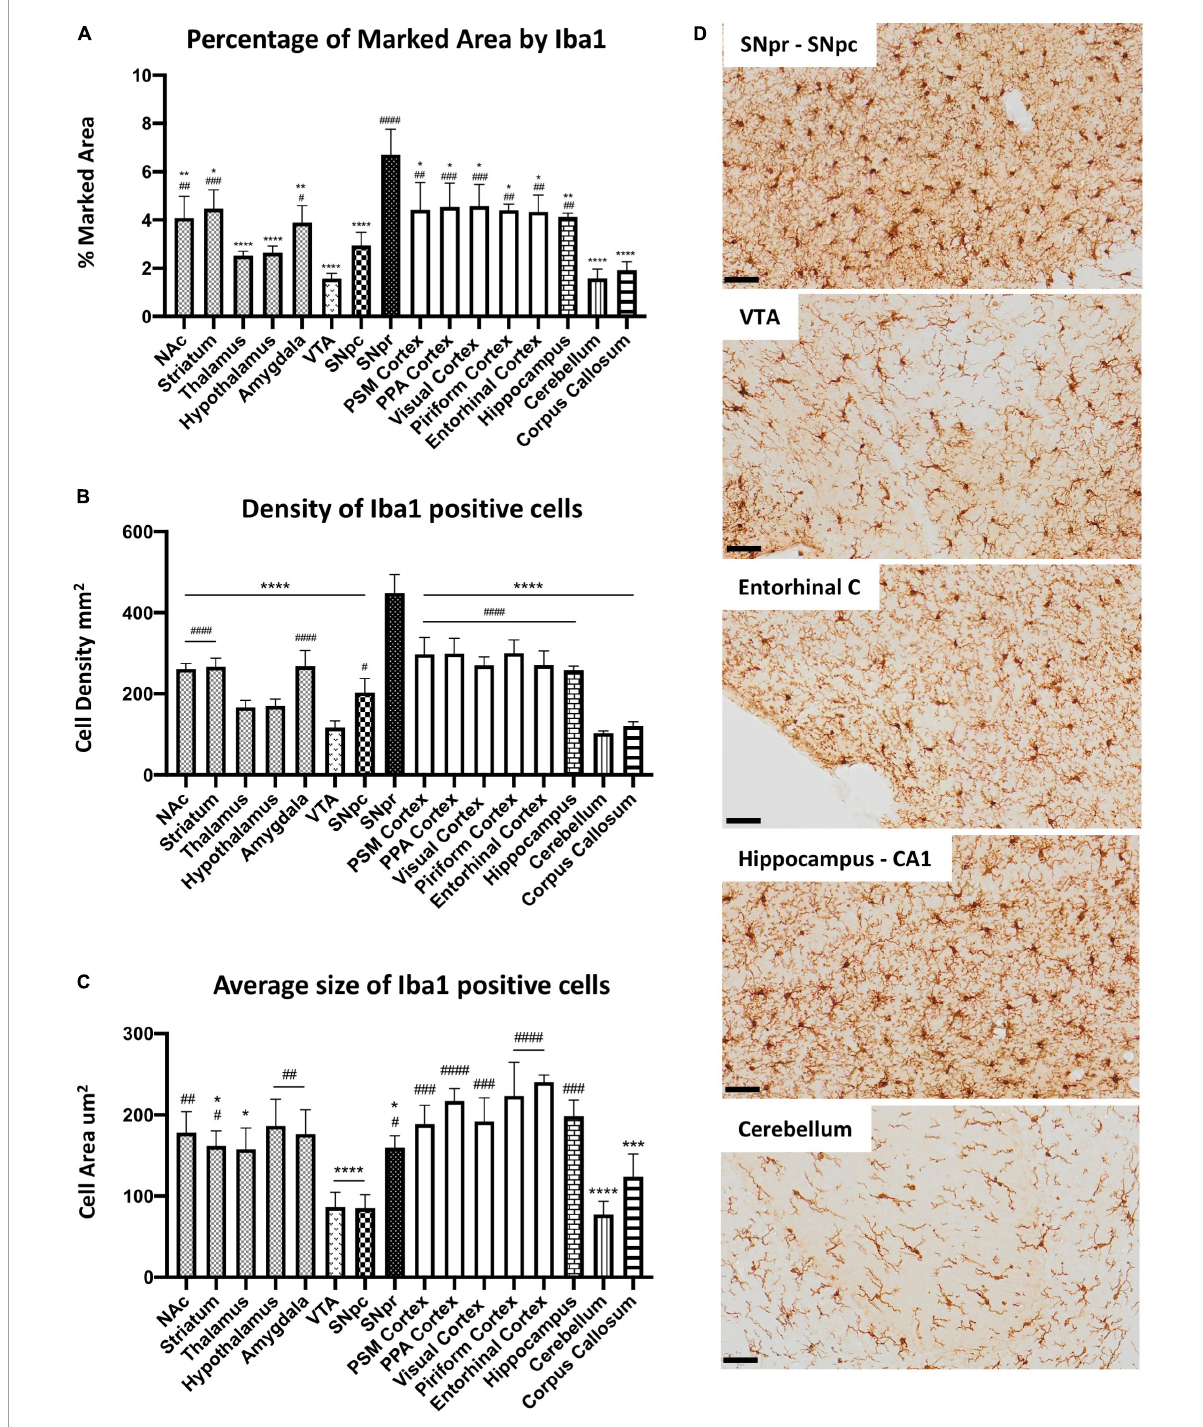
FIGURE1 Microglial heterogeneity in C57BL6N mice. (A) Percentage of the marked area by Iba1 in vehicles C57BL6N mice. One-way ANOVA F BrainRegions (15, 32) = 12.06, p < 0.0001, and n = 3 mice per region. Significance: (*) respect SNpr; (#) respect VTA. Other significances are summarized in Supplementary Table 1 . (B) Iba 1 positive cell density per mm 2 . One-way ANOVA F BrainRegions (15, 32) = 29.35, p < 0.0001, and n = 3 mice per region. Significance: (*) respect SNpr; (#) respect VTA. Other significances are summarized in Supplementary Table 2 . (C) Average size of Iba1 positive cells. One-way ANOVA F BrainRegions (15, 32) = 12.65, p < 0.0001, and n = 5 cells per region, and n = 3 mice per region. Significance: (*) respect Entorhinal cortex; (#) respect VTA and SNpc. Other significances are summarized in Supplementary Table 3 . (D) Representative images of Iba 1 staining in SNpr, SNpc, VTA, entorhinal cortex, hippocampus (CA1), and cerebellum. Scale bar (D) = 50